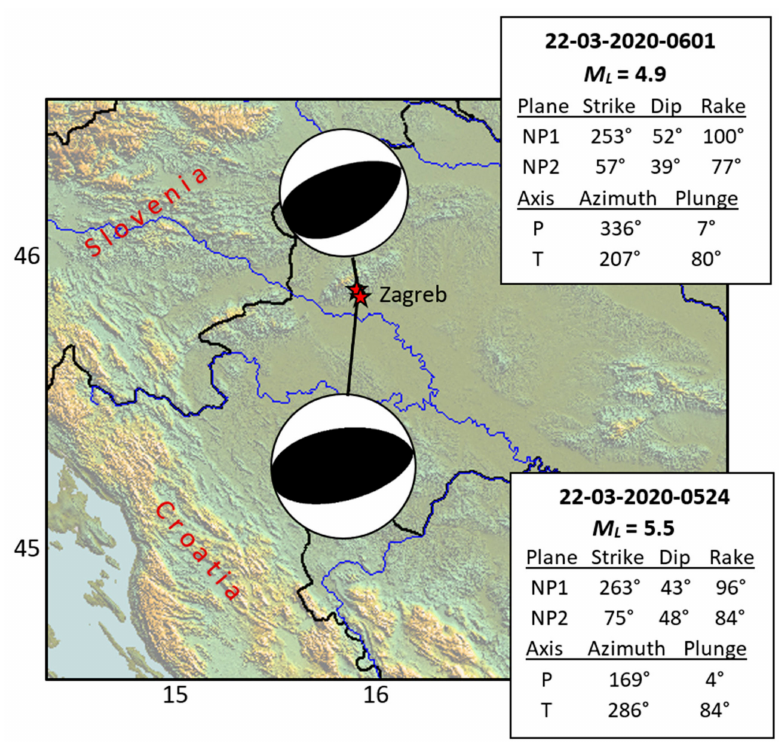
Figure 4. Fault-plane solutions of 22 March 2020 earthquakes at 05:24 UTC and 06:01 UTC. The focal sphere is shown in stereographic projection.